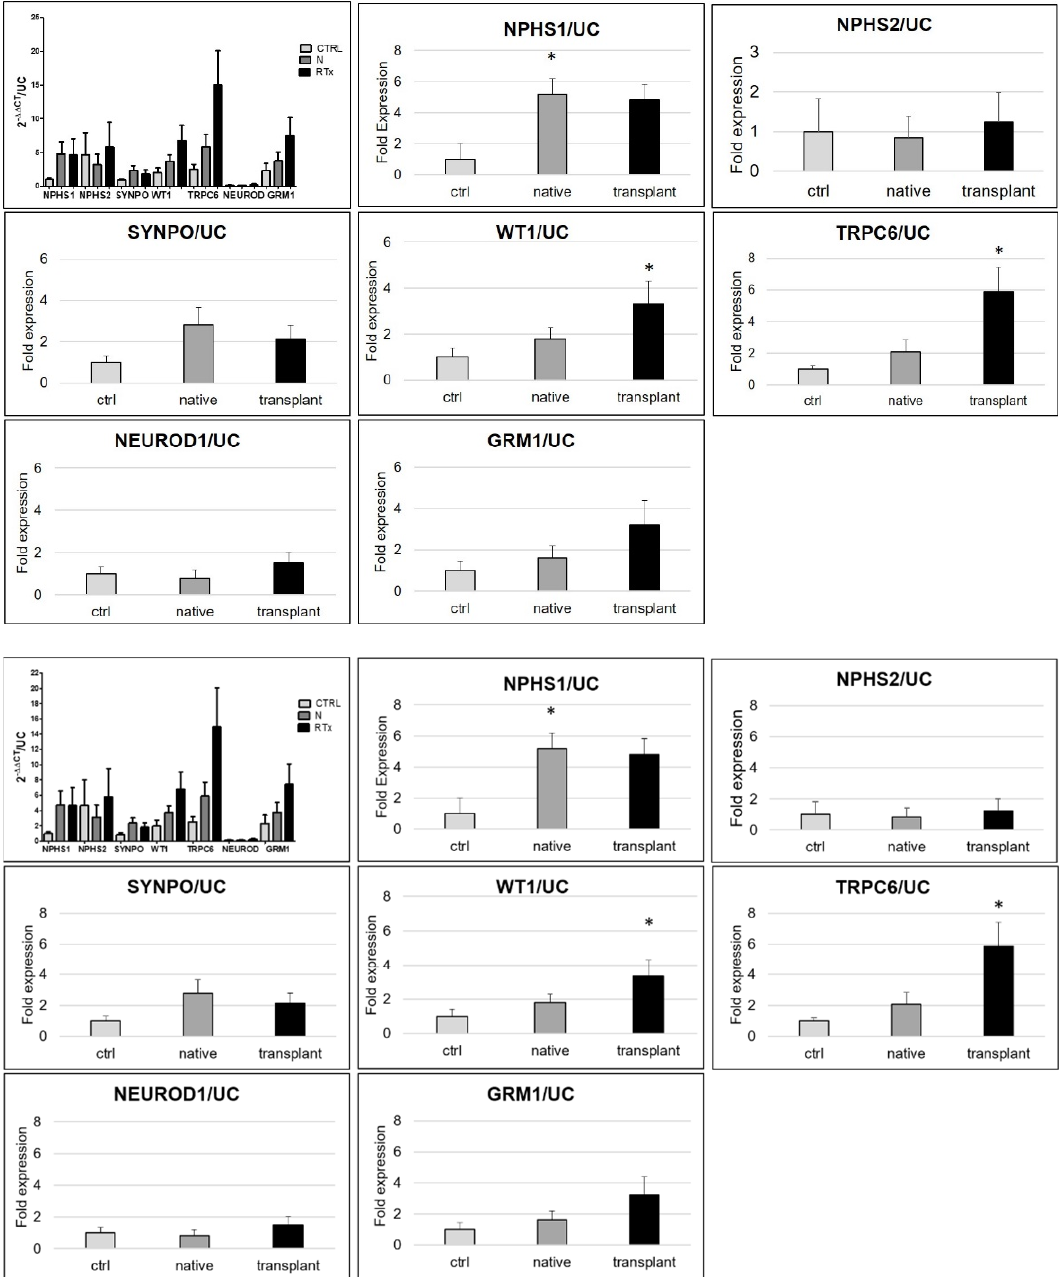
Figure 4. mRNA quantification of urinary cells. mRNA expression was measured in CTR, N, and RTx by RTqPCR, relative to GAPDH and corrected with UC. In the first image top left, the values are expressed as 2 − ∆∆ ct /UC as mean ± standard error to display the amount of gene expression in each group of the sample. Differently, in the subsequent histograms, the results are expressed relative to the control group as mean fold expression ± standard error, to compare the groups. Significance * p < 0.05.